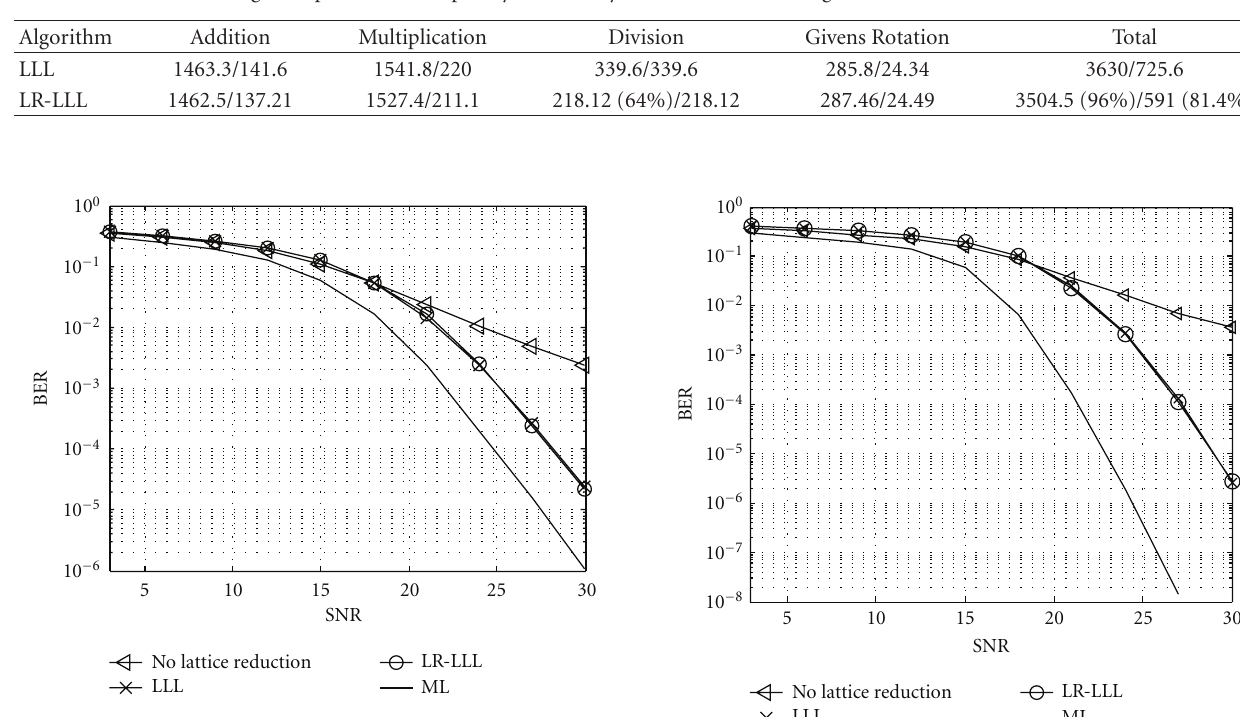
Table 4: Average computational complexity and latency of lattice-reduction Algorithms for 8 × 8 MIMO detection.